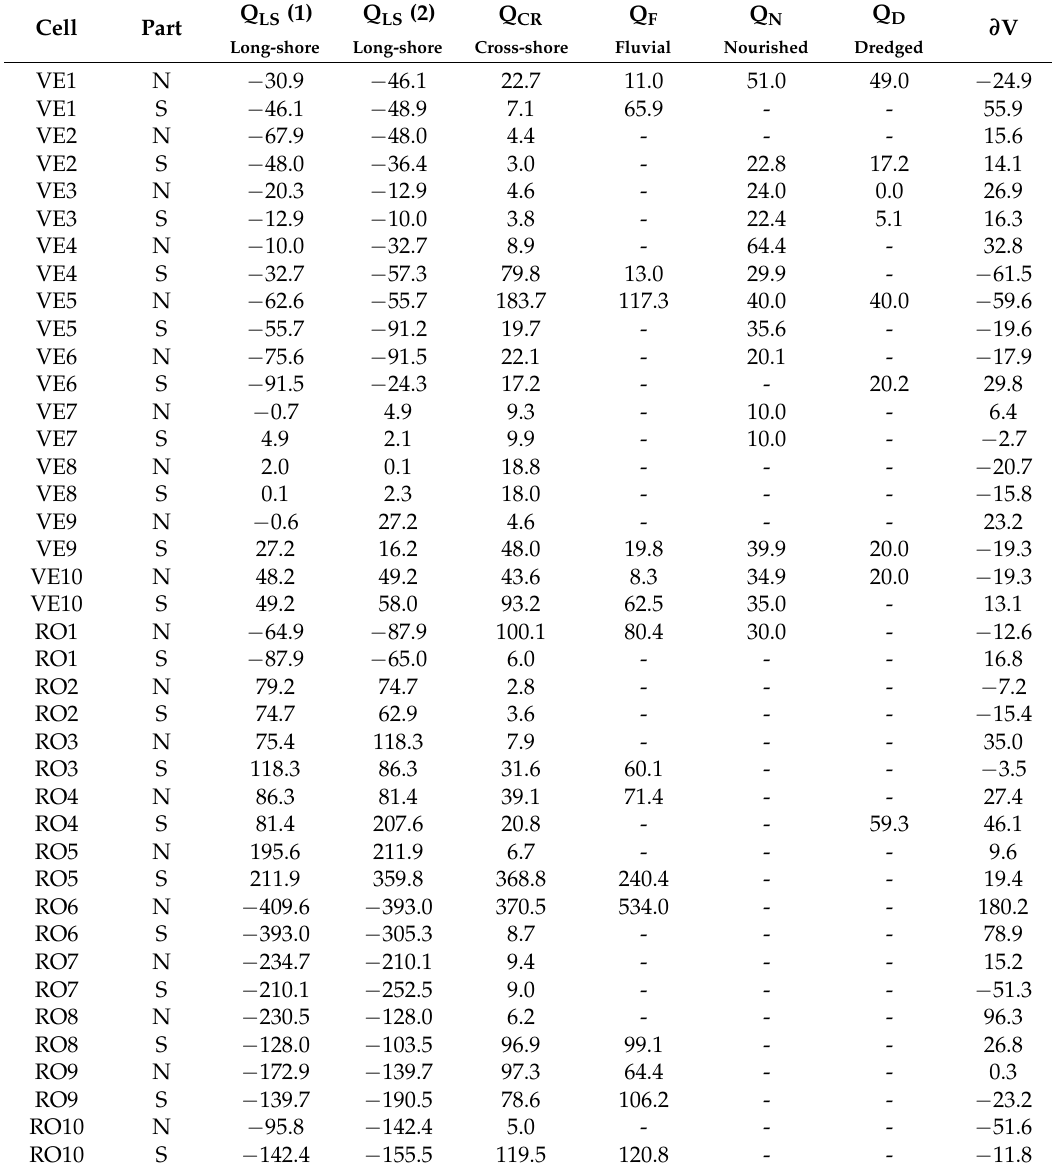
Table 3. Sediment balance (thousand m 3